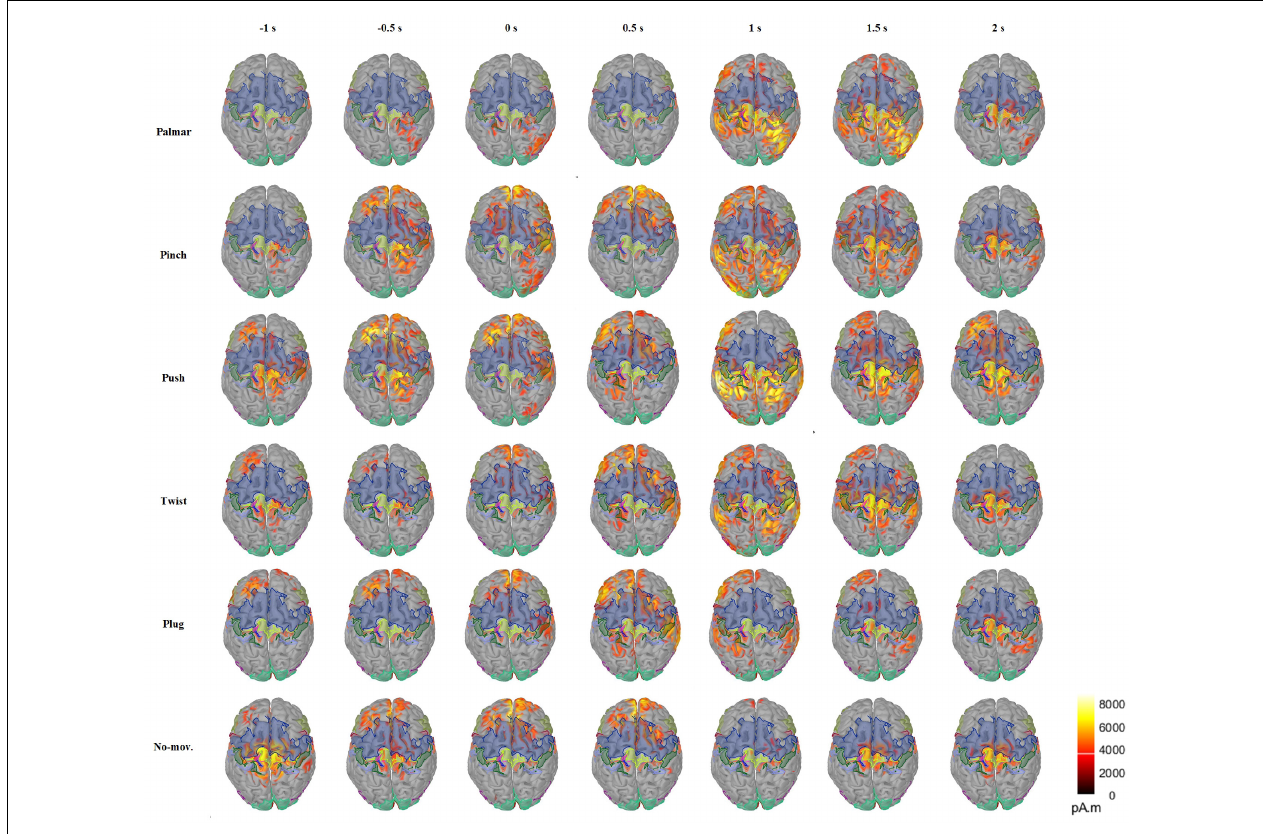
FIGURE 5 | Average cortex maps’ changes for all the conditions of S2 in the time of [ − 1, 2] s, with 0 s corresponding to the movement onset. In this figure, the activity of sMRCP less than 40% of the maximum activation amplitude was filtered.